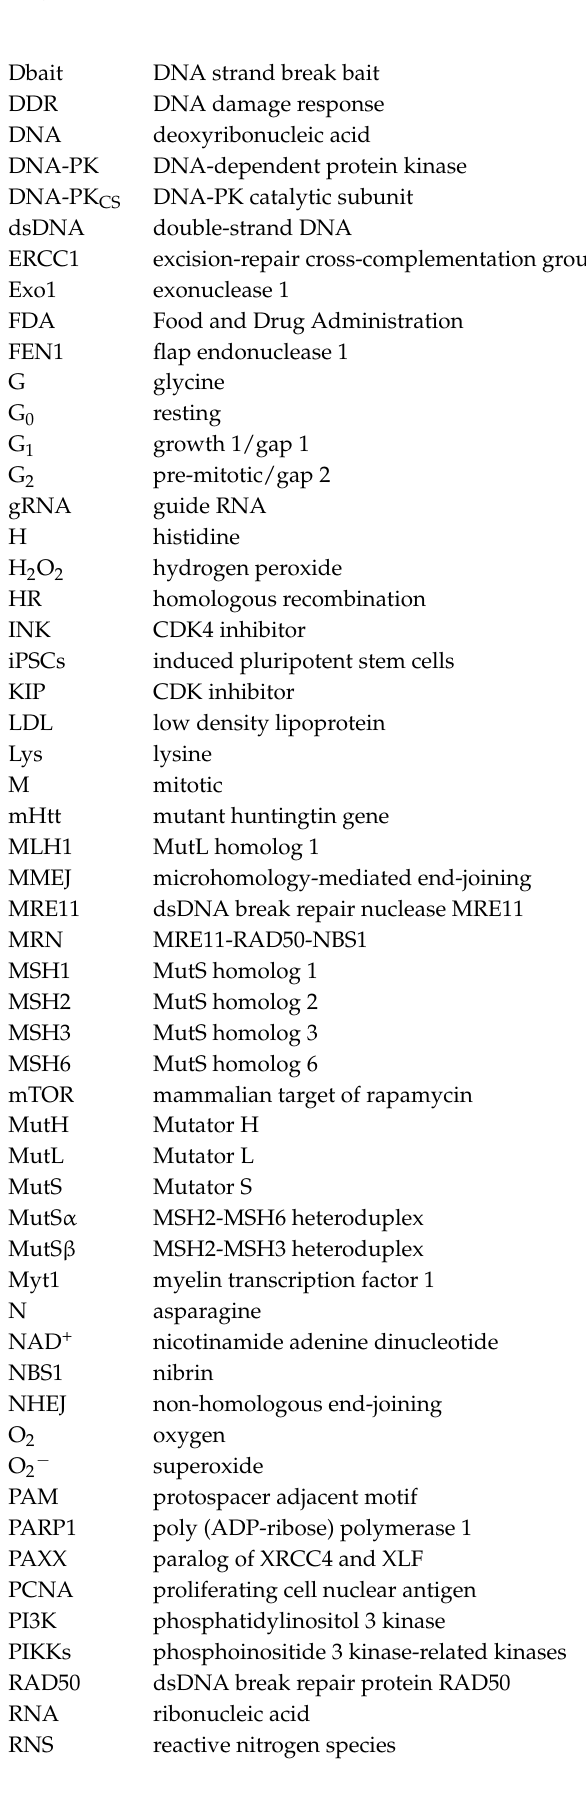
DNA damage response DNA deoxyribonucleic acid DNA-PK DNA-dependent protein kinase DNA-PK